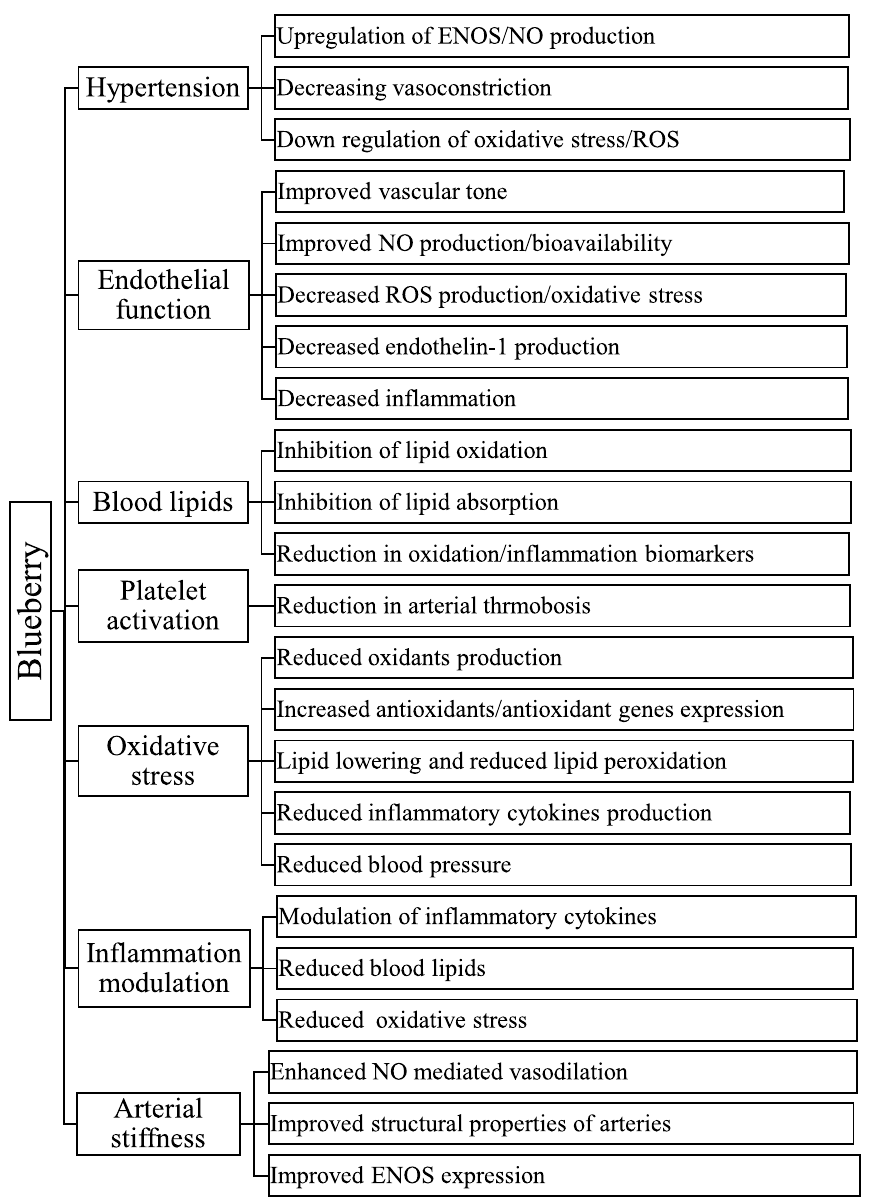
Fig. 2 Mechanisms of CVD protection by blueberry and blueberry polyphenols and anthocyanins. ENOS (endothelial nitric oxide synthase), NO (nitric oxide), ROS (reactive oxygen